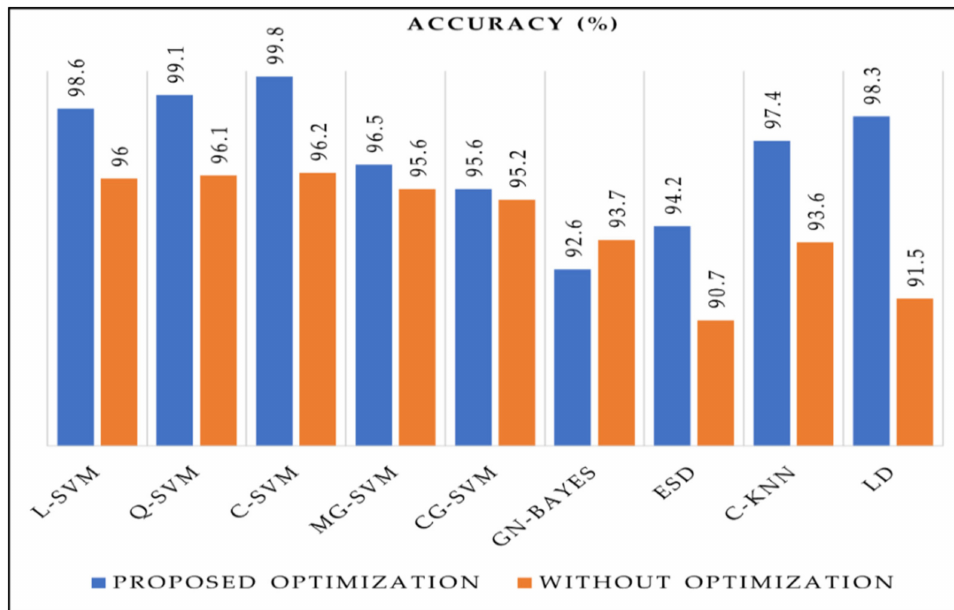
Figure 9. Stomach disease recognition accuracy with and without optimization.